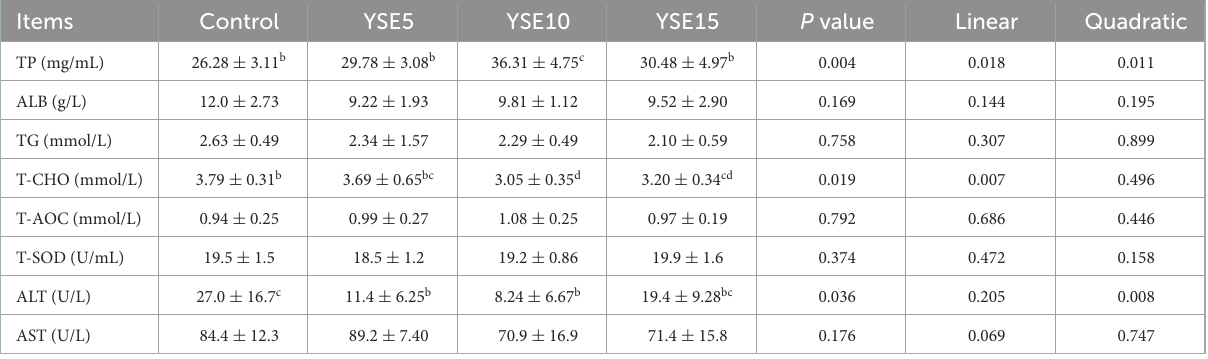
TABLE 4 Effects of supplemental different levels of YSE on serum biochemical parameters of young pigeons a . Items Control Linear Quadratic